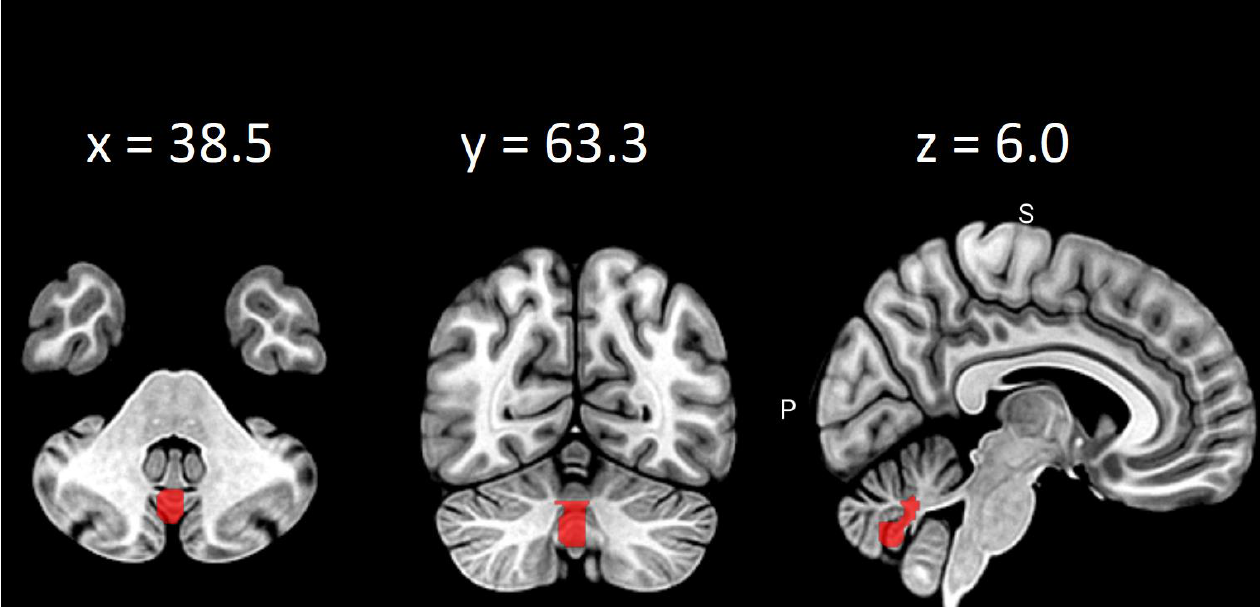
Brain Sci. 2021 , 11 , x FOR PEER REVIEW Figure 2. Scatter plot for PANAS anhedonia scores and clustering coefficient on 0.2 threshold of vermis VIII.